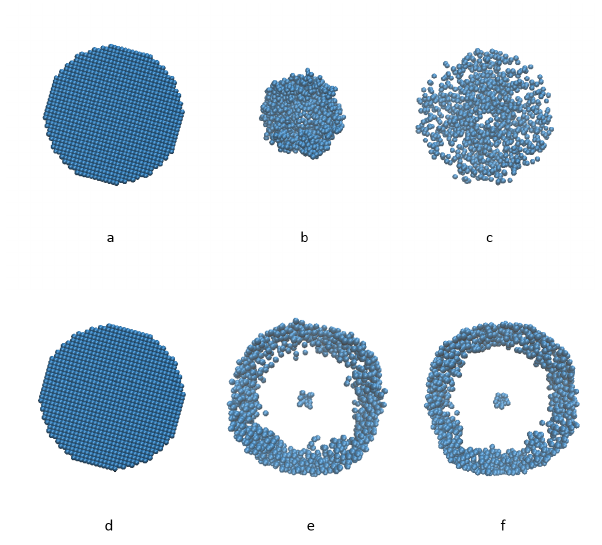
Figure 16. Liquid distribution comparison of high viscosity and low viscosity at different time ( a ) ν = 1 m 2 /s t = 0 ( b ) ν = 1 m 2 /s t = 2 s ( c ) ν = 1 m 2 /s t = 5 s ( d ) ν = 0.04 m 2 /s t = 0 ( e ) ν = 0.04 m 2 /s t = 2 s ( f ) ν = 0.04 m 2 /s t = 5